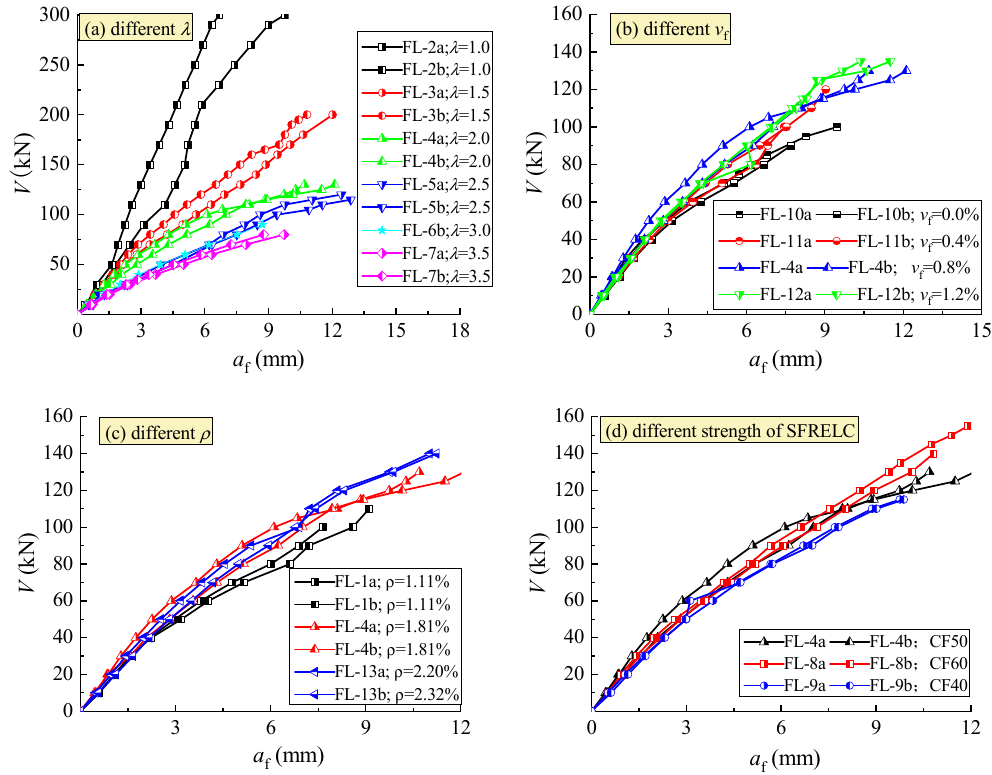
Figure 6. Load vs. mid-span deflection curve of test beams. ( a ) Different λ ; ( b ) Different v f ; ( c ) Different ρ ; ( d ) Different strength of SFRELC.